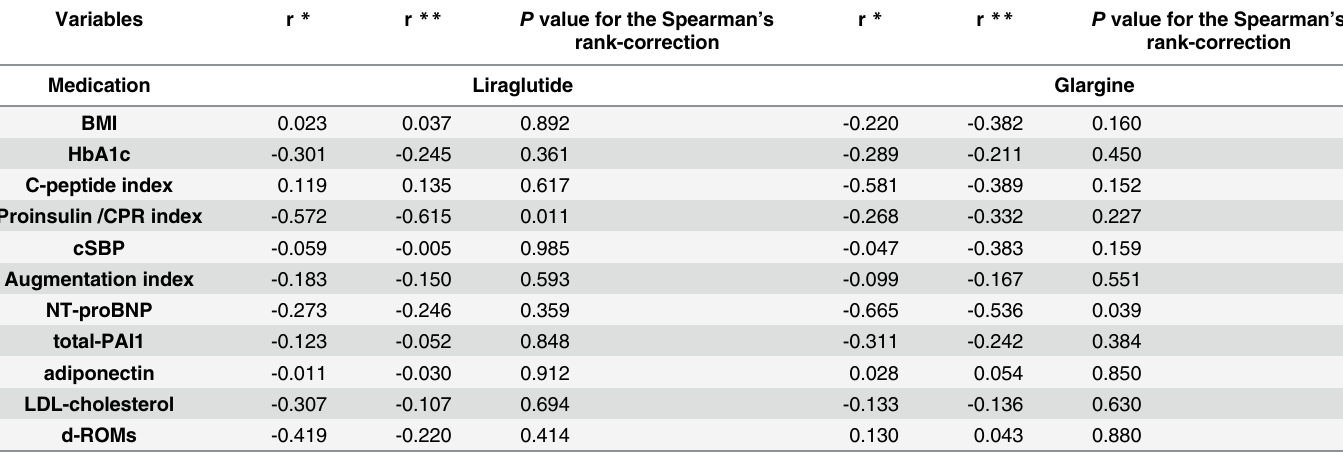
Table 4. Relationship between the changes in %FMD and other metabolic parameters pre- and post-treatment with liraglutide or glargine.